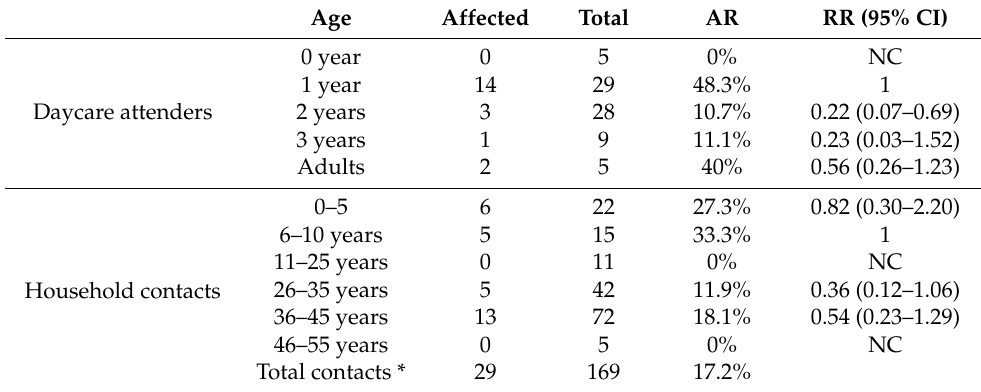
Table 1. Attack rates and risk ratio in day care center attenders and household contacts according to age.